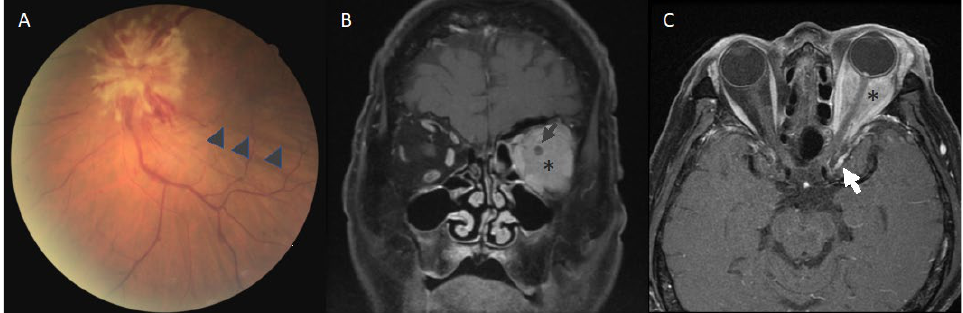
Figure 1. ( A ) Fundoscopy of the left eye showed a prominent swollen disc, retinal venous dilatation, and chorioretinal folds (arrowhead). ( B ) Coronal magnetic resonance imaging (MRI) (T1W1) demonstrated the left retrobulbar mass (aristek) encasing the optic nerve (arrow). ( C ) Axial MRI (T1W1) showed a homogenous lesion (aristek) extending from the left peribulbar space to the cavernous sinus (arrow).